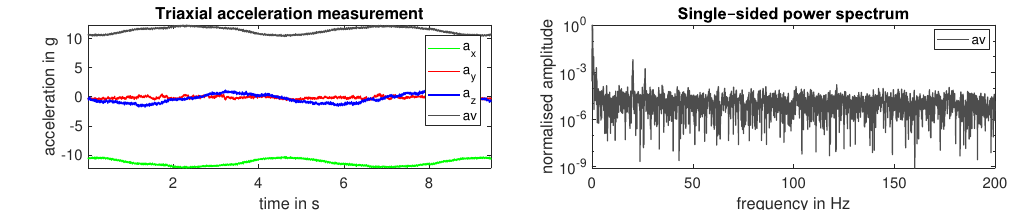
Figure 5. ( Left ) Exemplary triaxial measurement a i and corresponding vector sum av displayed in the time domain, i = x , y , z . Acceleration measured at f s = 400Hz and denoted with reference to gravitational acceleration (1g = 9.81ms − 2 ). ( Right ) Single-sided power spectrum S(k) for the exemplary measurement, computed from the vector sum av